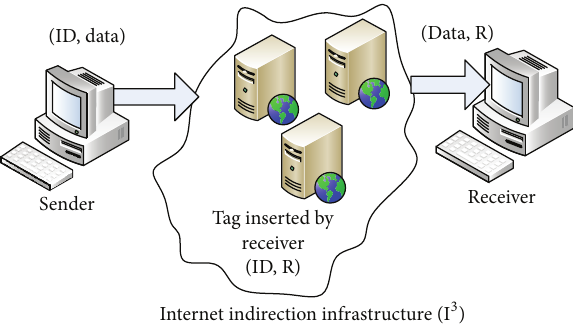
Figure 2: An abstract view of ID/Locator split based